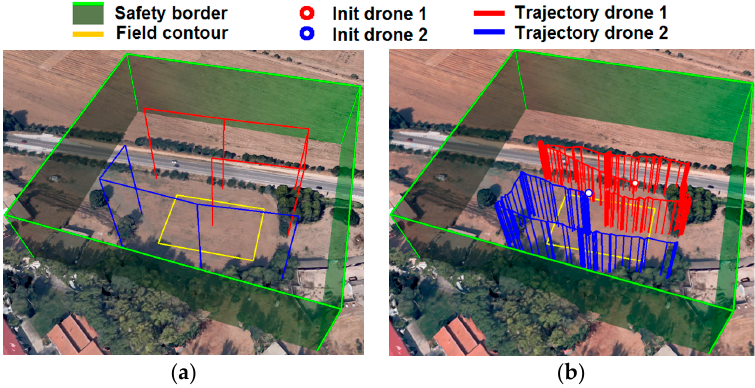
Figure 9. Inspection aerial mission: ( a ) Planned trajectories and ( b ) actual trajectories.